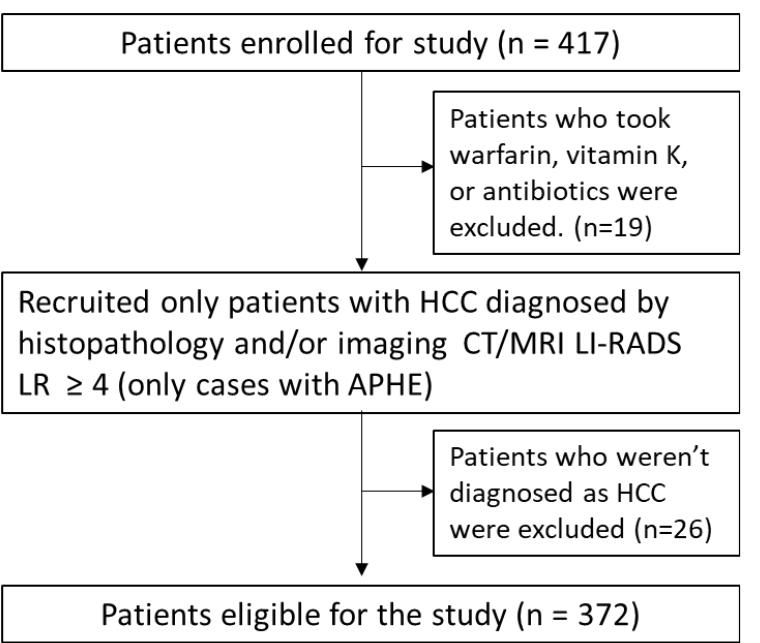
Figure 1. Flowchart of patient selection. Initially, 417 patients with HCC were enrolled, but 19 were excluded for taking warfarin or antibiotics. Only patients with HCC that was diagnosed by histopathology and/or imaging were selected, and 26 patients were excluded. Finally, 372 patients were selected for this study. LI-RADS, Liver Imaging Reporting and Data System; APHE, arterial phase hyperenhancement.